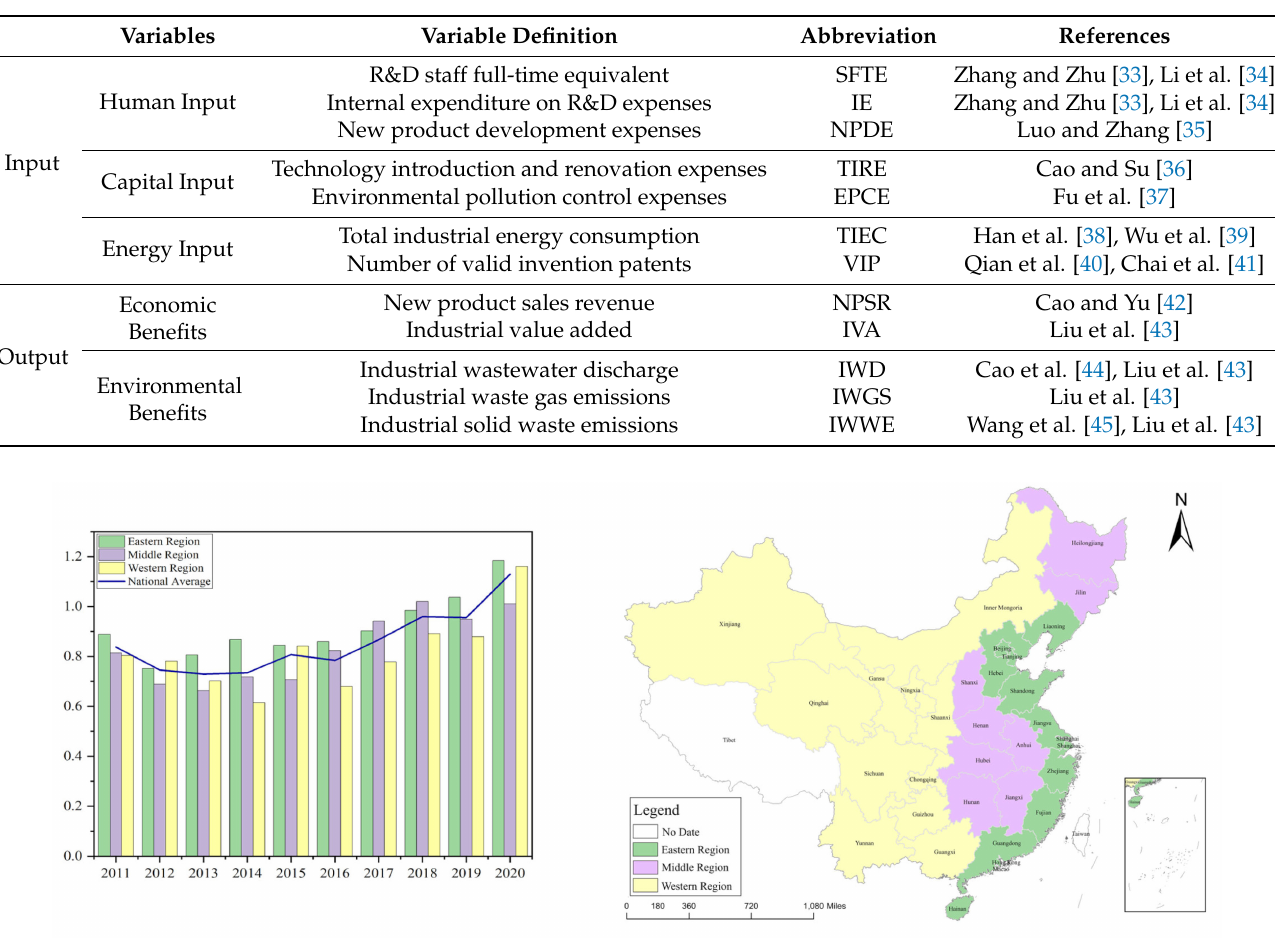
Figure 1. Regional green innovation efficiency comparison